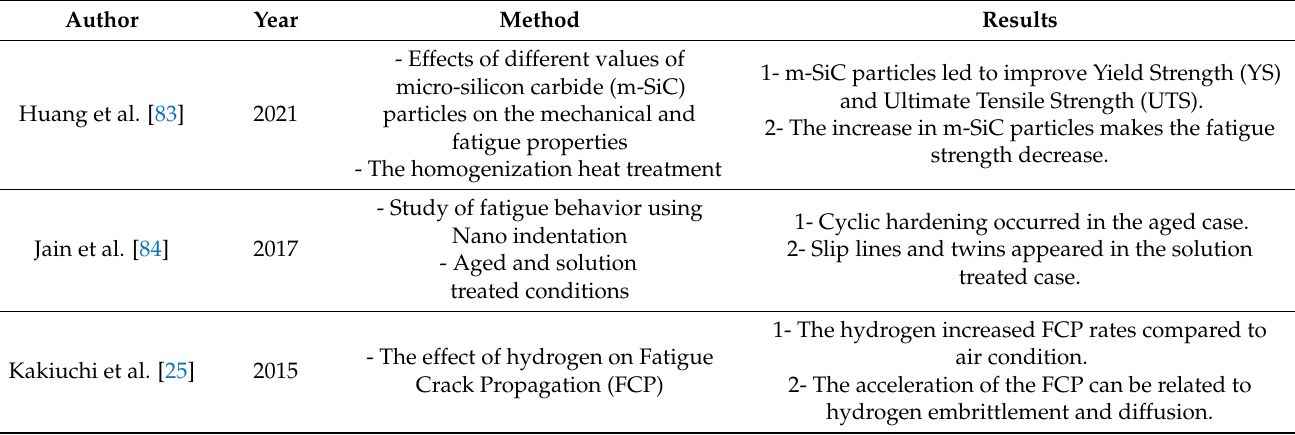
Table 7. The summary of novel research on the AZ61 magnesium